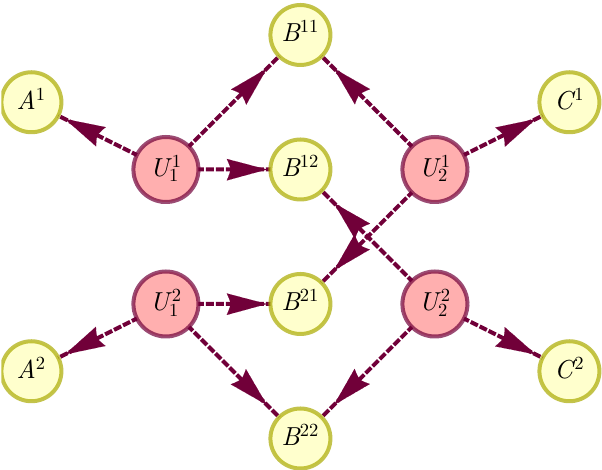
Figure 6: The second-order inflation graph of the three-on-line